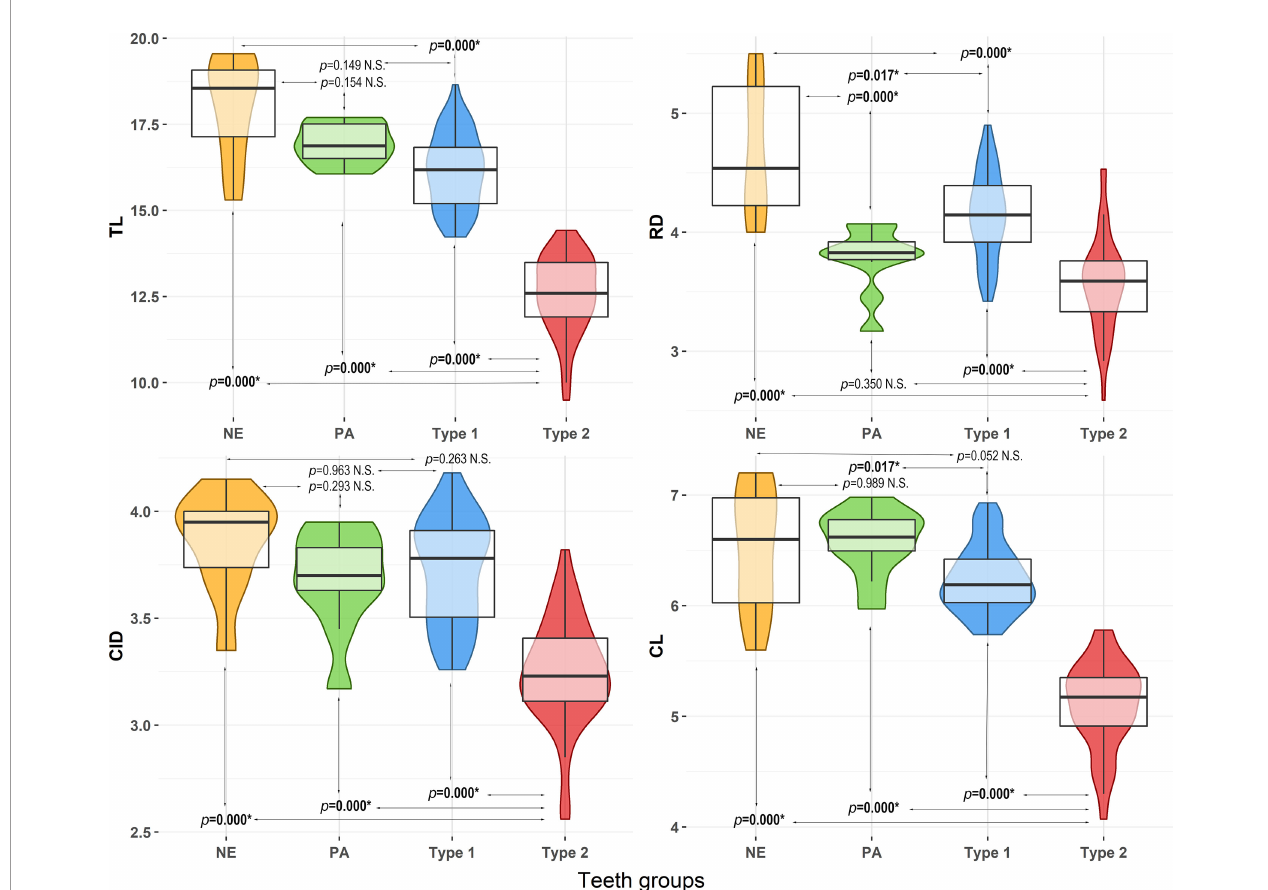
FIGURE 5 | Violin data representation and pairwise comparison between groups of teeth for the measurements of total length (TL), root diameter (RD), cingulum diameter (CID), and crown length (CL). Type 1 and Type 2 comprised groups of teeth resulting from cluster analysis and the localities of Para ́ coast (PA) and Northeast Brazil (NE) comprised only stranded specimens of Sotalia guianensis used as control groups. Box represents values between the fi rst and third quartile, the horizontal dark line represents the median, and vertical lines inside the violin shapes represent the lowers and upper values. Bold and asterisk in p-values indicate signi fi cant differences from pairwise comparisons for p<0.05; N.S., indicates non-signi fi cant